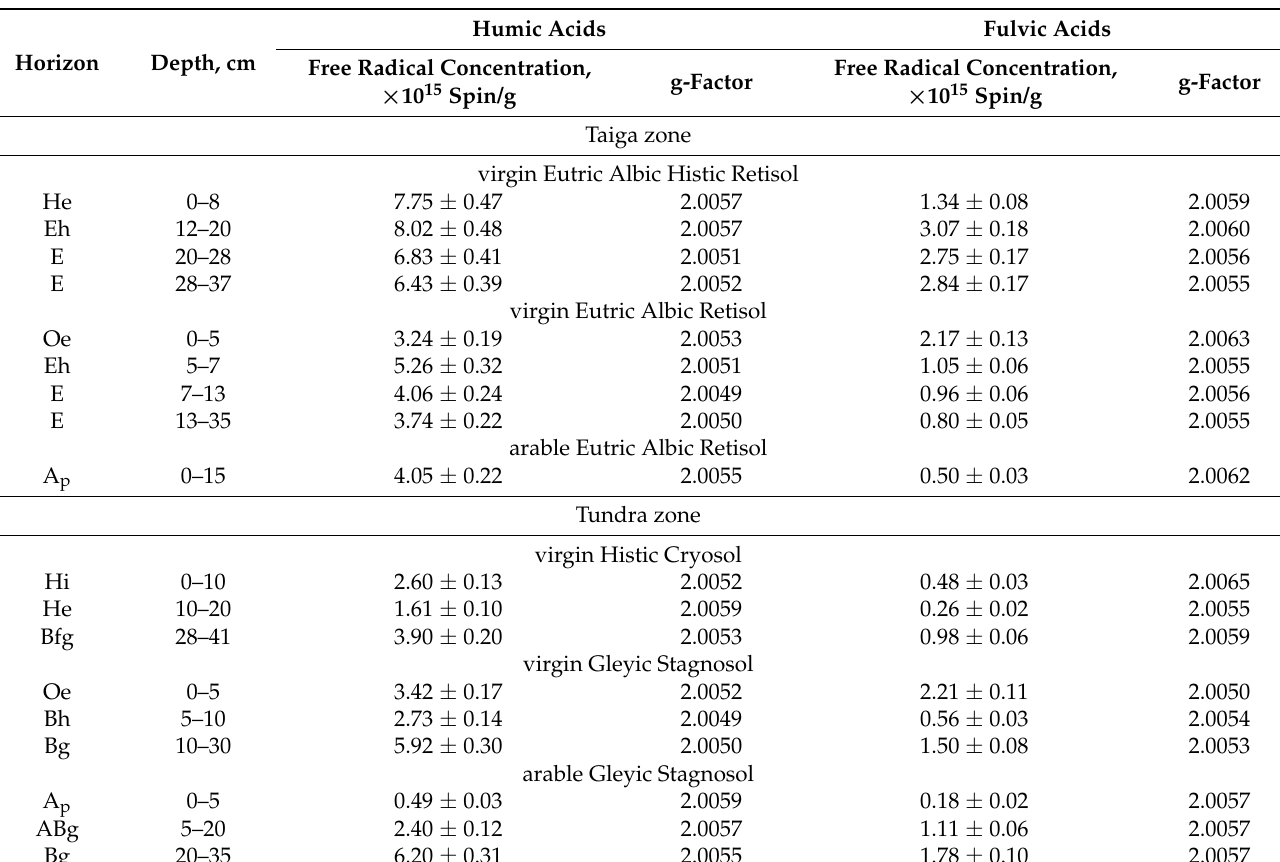
Figure 2. A typical EPR spectrum of the HSs (within the region of the g-factor of 2.003), based on a HA sample from the Eh horizon of Eutric Albic Histic Retisol. Table 3. Paramagnetic properties of humic and fulvic